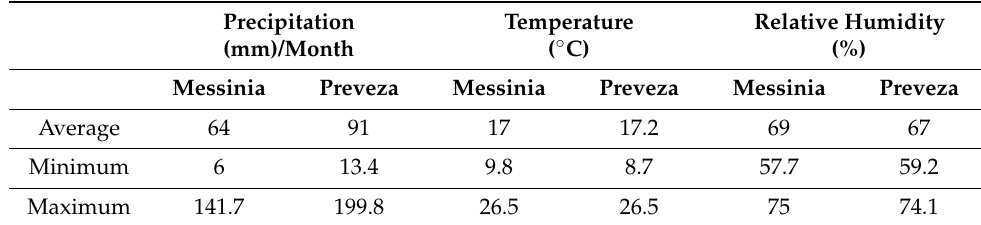
Table 1. The climatic parameters of the examined olive oil cultivation areas in Greece for the harvest year